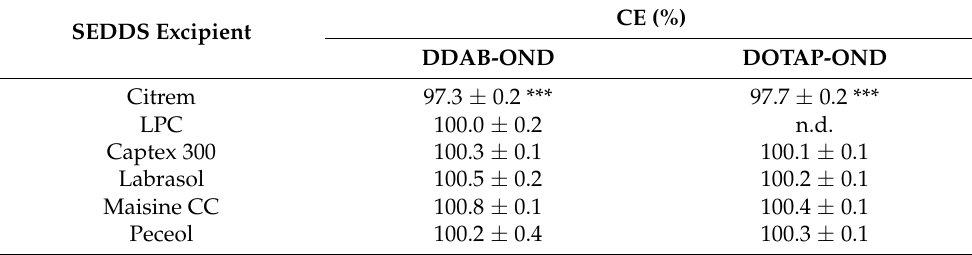
Table 4. Effect of SEDDS excipients on the complex stability. The complexation efficiency (CE %) after interactions with a SEDDS excipient is reported relative to the control where no SEDDS excipient was added (CE = 100%).